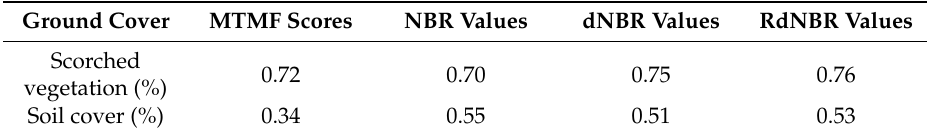
Table 2. Pearson correlation coefficients between ground values ( n = 40) and image pixels.